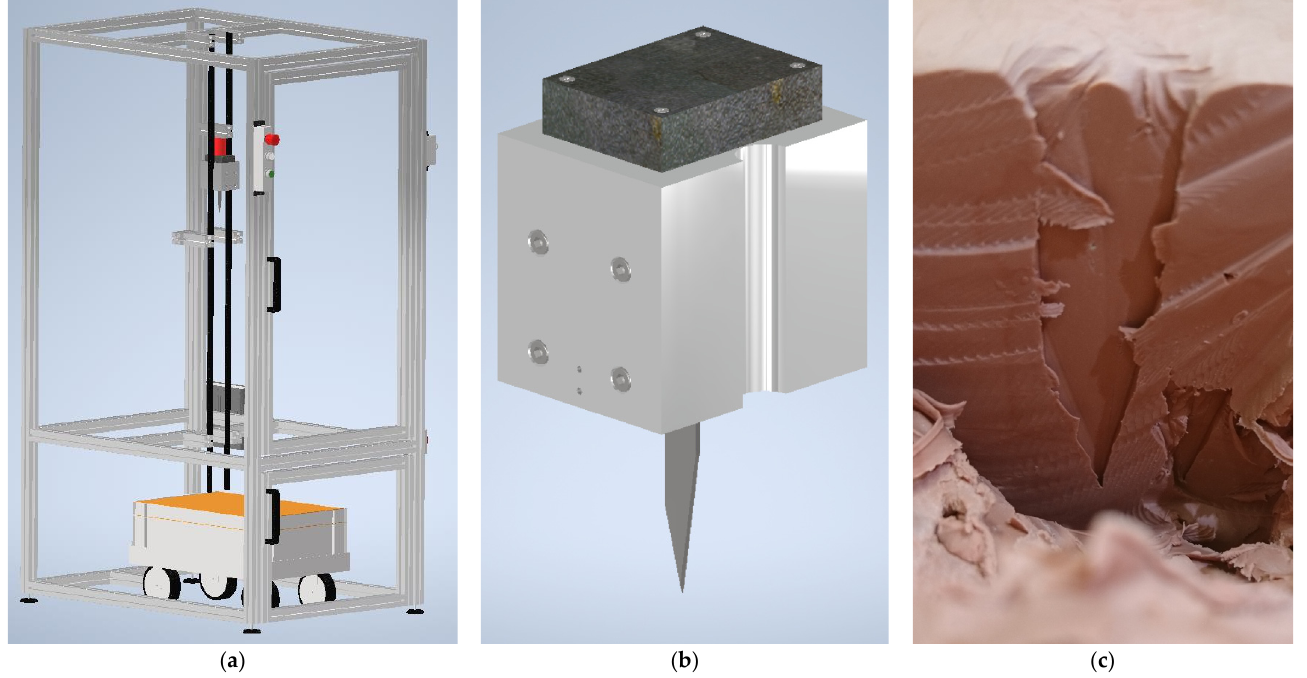
Figure 1. Stab resistance against knives: ( a ) test stand; ( b ) drop mass with standard blade; ( c ) stitch channel during excavation.